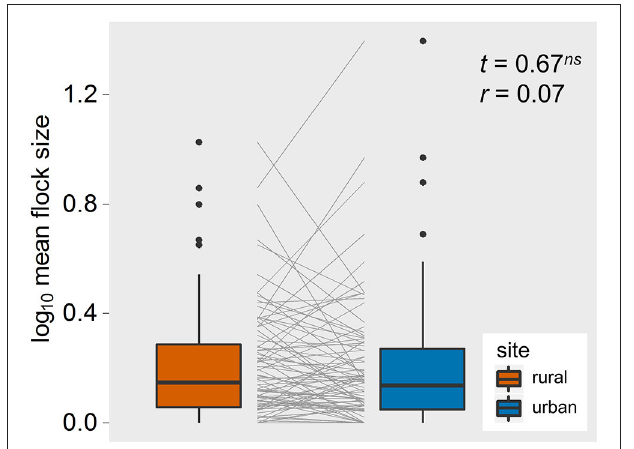
FIGURE 3 | The rural-urban differences in flock size of the 92 bird populations studied in Europe. Box-plots show median, quartiles, 5- and 95-percentiles and extreme values. Each species’ trajectory is illustrated with a gray line. t -values and effect sizes calculated as partial correlation coefficients are shown. ns, non-significant.